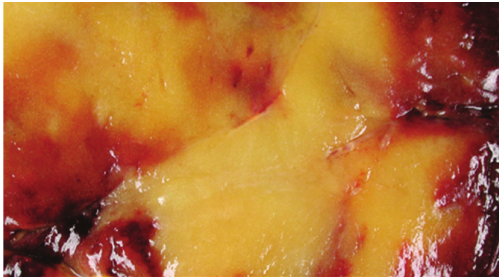
Figure 5: Cut surface of the resected mass: tan-brown to pale yellow color.